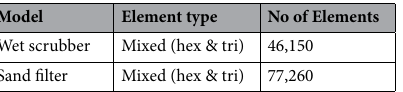
Table 2. Building a mesh for the wet scrubber and sand filter model.